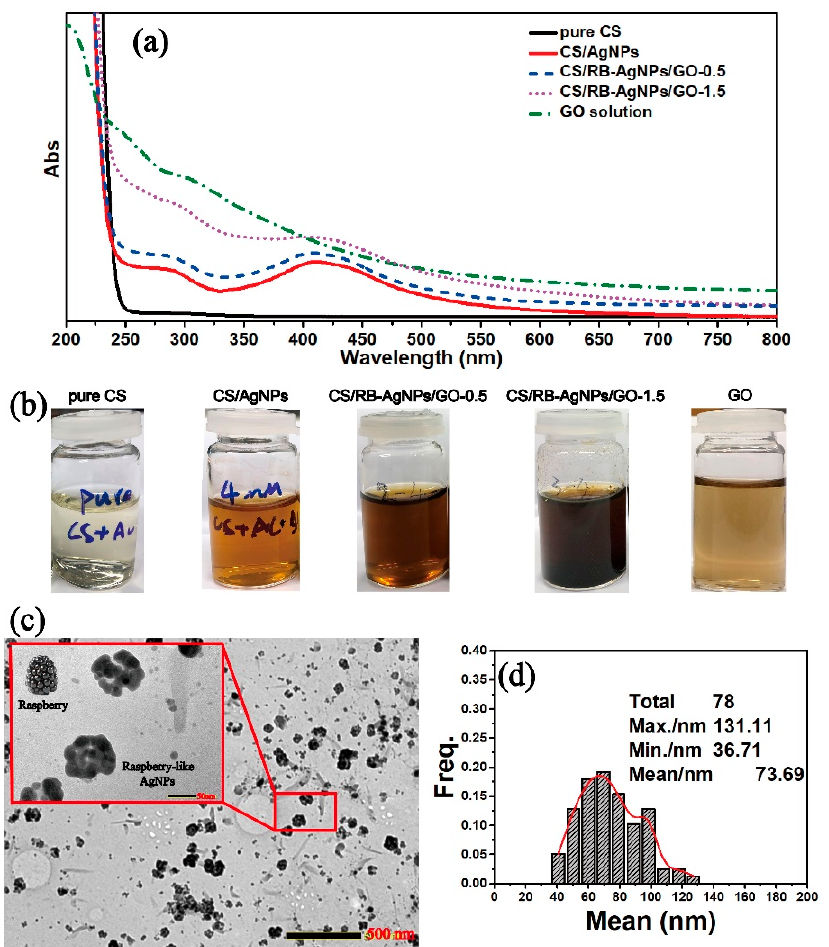
Figure 1. ( a ) UV-vis spectra of all sample solutions, ( b ) photographs of all sample solutions, ( c ) TEM image of the CS/RB-AgNPs/GO-1.5, and ( d ) RB-AgNPs particle size distribution within the CS/RB-AgNPs/GO-1.5 sample.